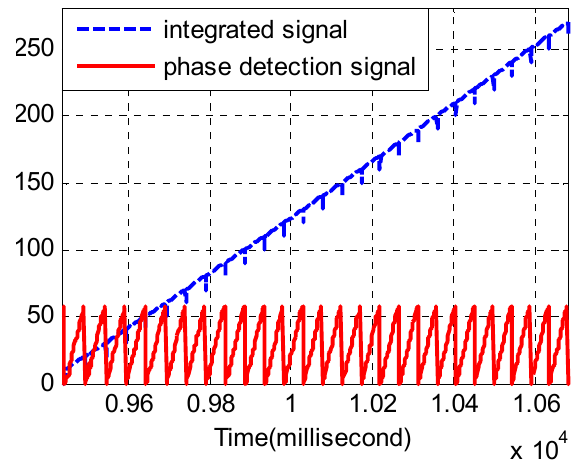
Figure 9. The phase detection and integrated signal in the forward direction.